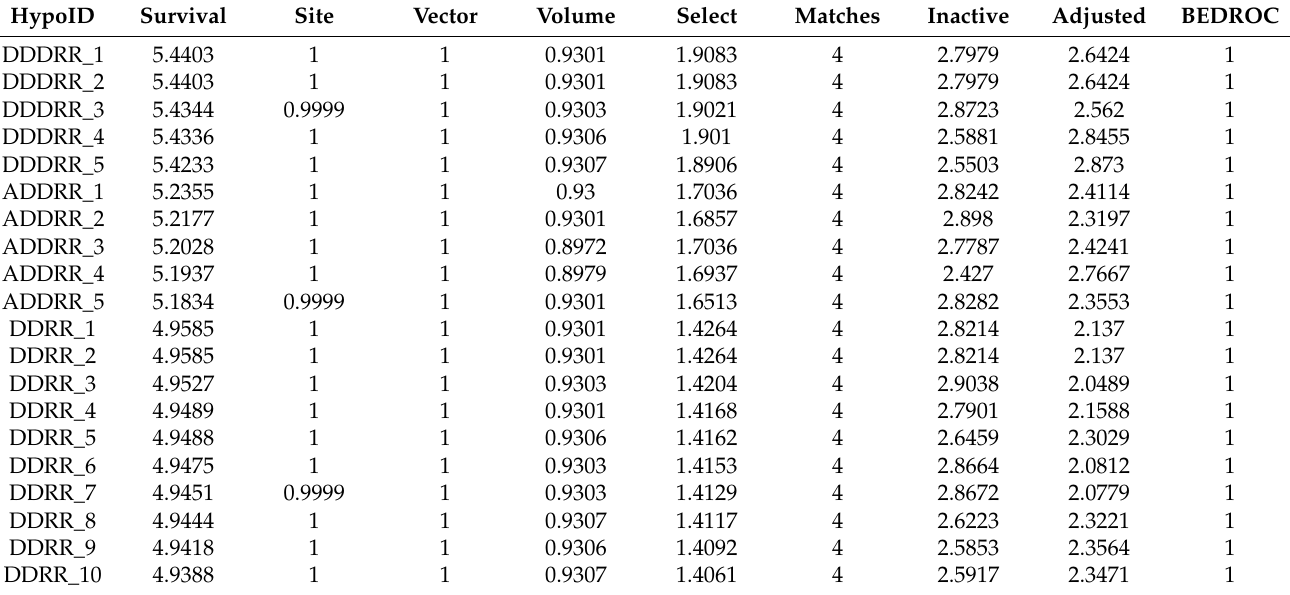
Table 2. Pharmacophore hypothesis with ranking on the basis of survival